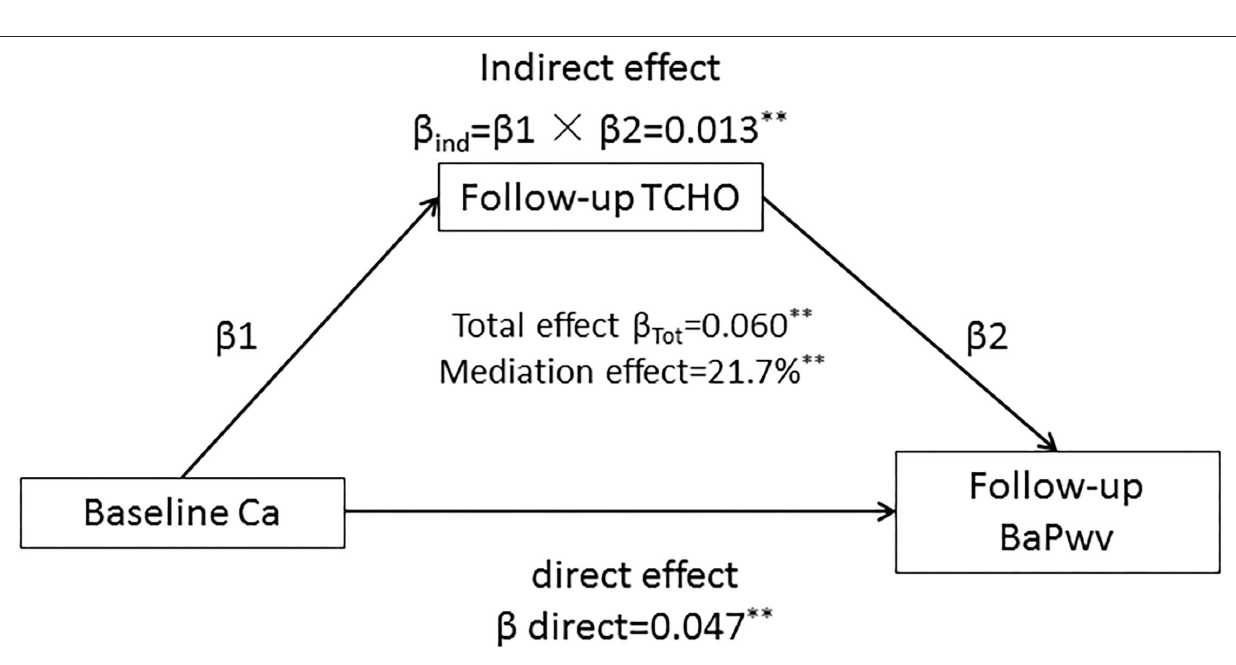
Frontiers in Nutrition |